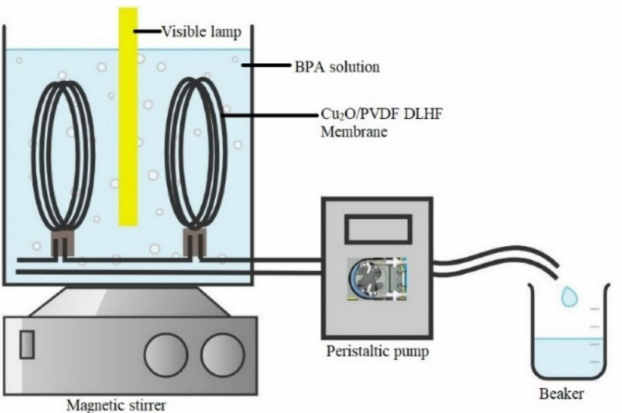
Figure 1. Schematic diagram of pilot-scale submerged photocatalytic membrane